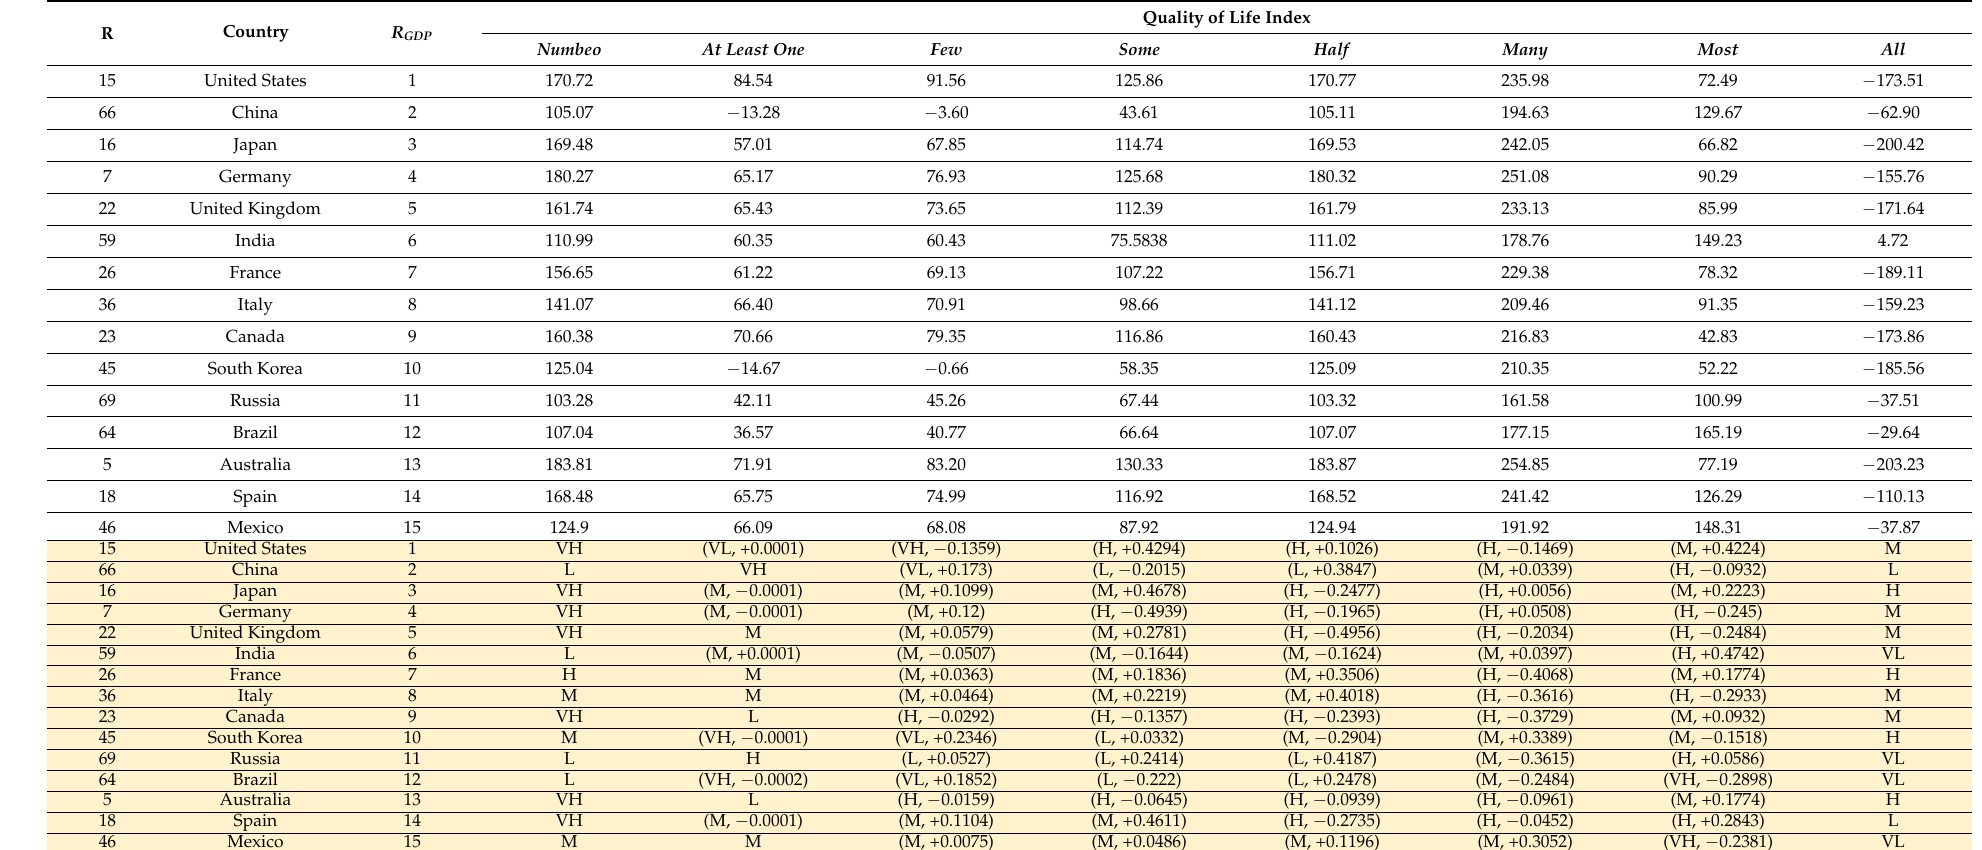
The results of the 2-tuple value are marked with an orange